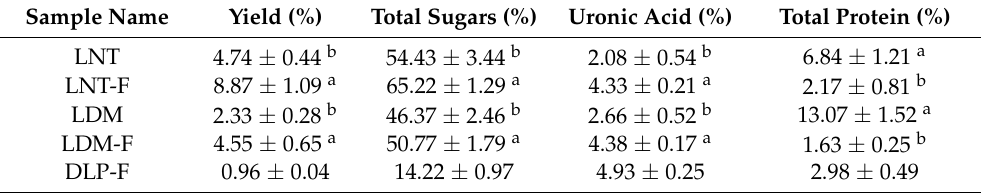
Table 1. Extraction yield and chemical composition of fermented and unfermented